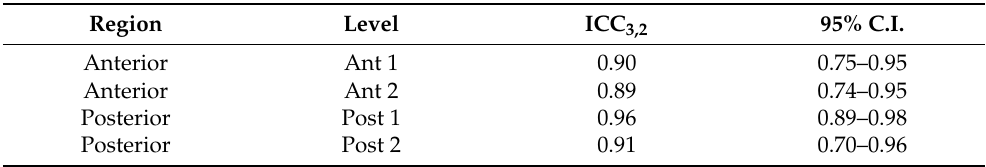
Table 8. Intra-rater reliability of the ultrasound measurements within different regions/levels of the superficial fascia of the forearm between two sessions by